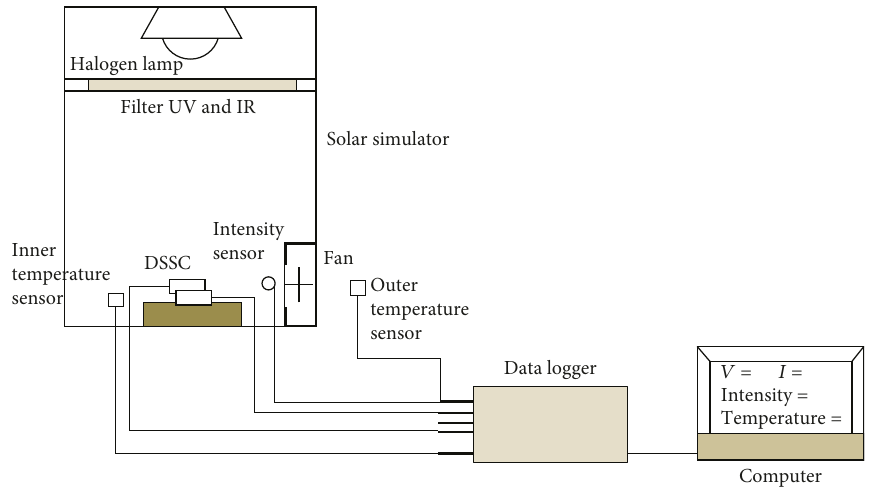
Figure 5: Research installation